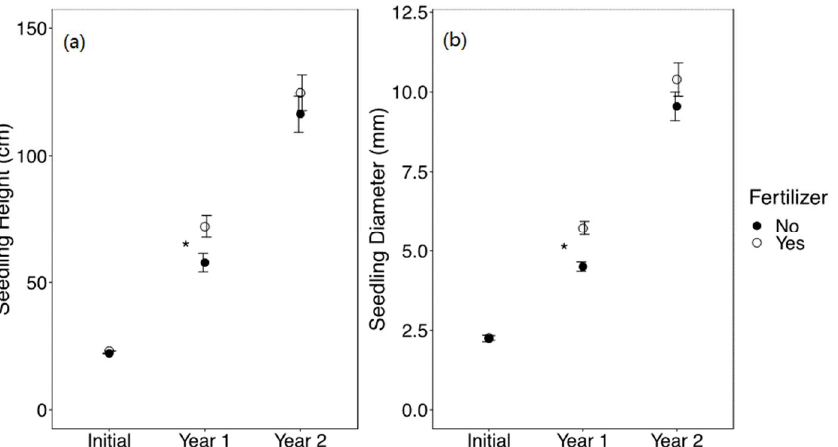
Figure 5. Mean ± SE ( a ) height (cm) and ( b ) diameter (mm) of Quercus virginiana seedlings at the time of planting (initial), after the first growing season (Year 1), and after the second growing season (Year 2). Seedlings either did not receive fertilizer or received 20 g of fertilizer. Asterisks indicate significant differences among the fertilizer treatment levels (α = 0.05).